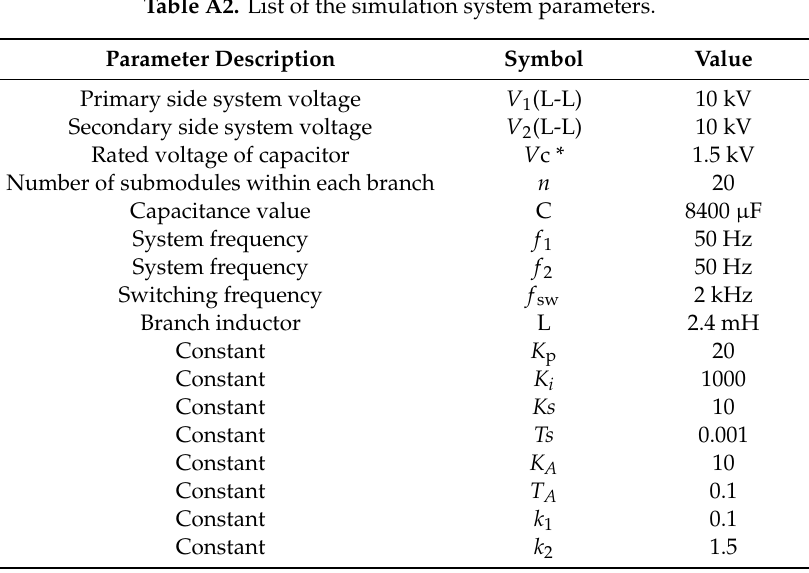
Table A2. List of the simulation system